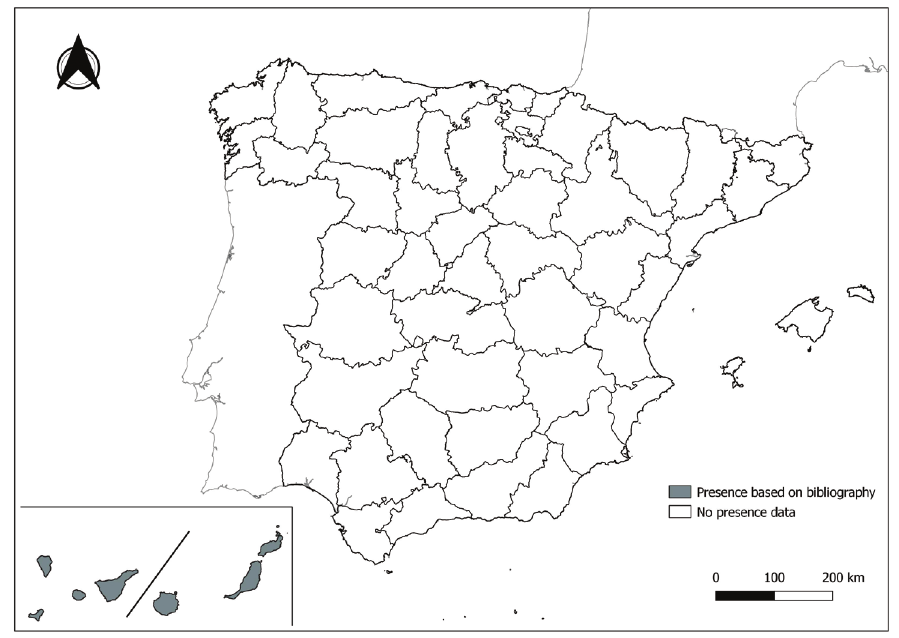
Figure 13. Distribution of Phlebotomus fortunatarum in Spain. Note its absence from peninsula